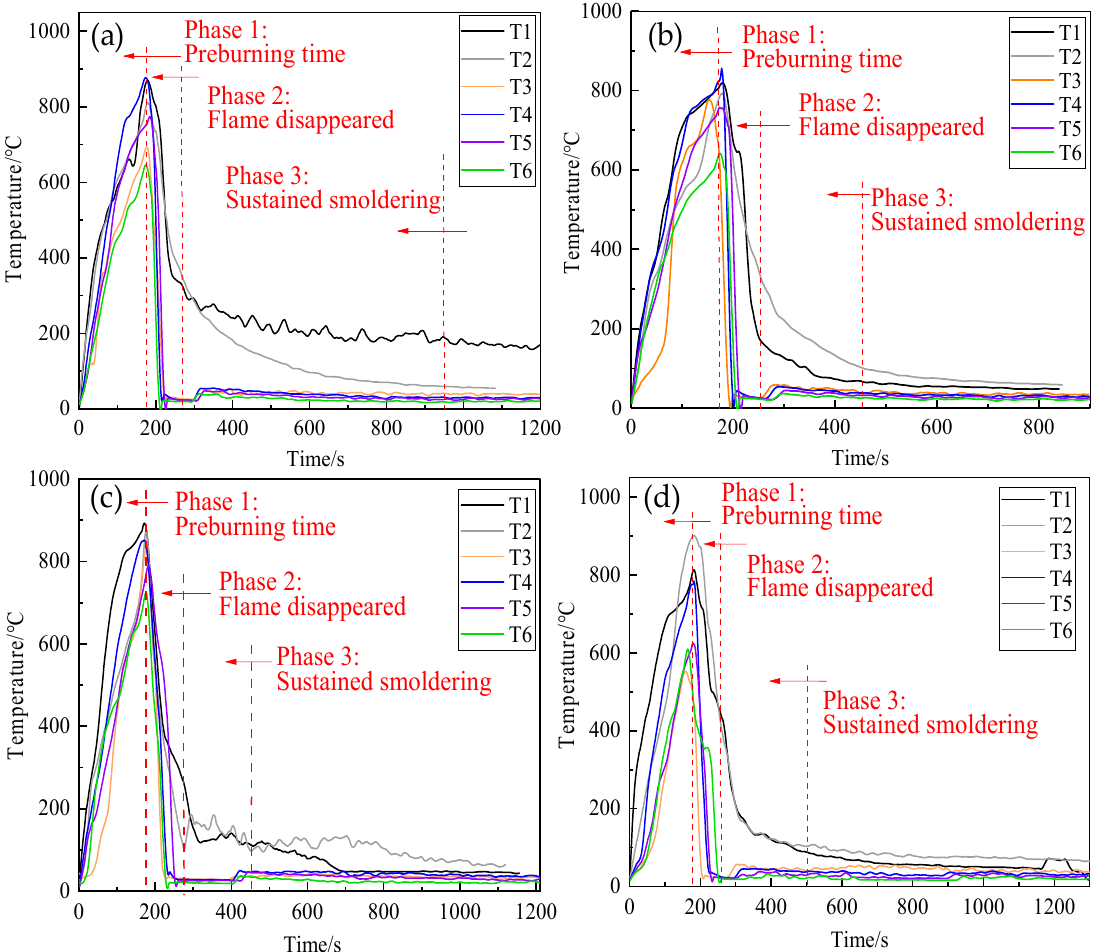
Figure 8. Variation of flame temperature in the tests with four samples as suppressants: ( a ) 2 wt% thermosensitive hydrogel; ( b ) 4 wt% thermosensitive hydrogel; ( c ) 6 wt% thermosensitive hydrogel; ( d ) 8 wt% thermosensitive hydrogel. Table 1. Fire extinguishing performance of the four